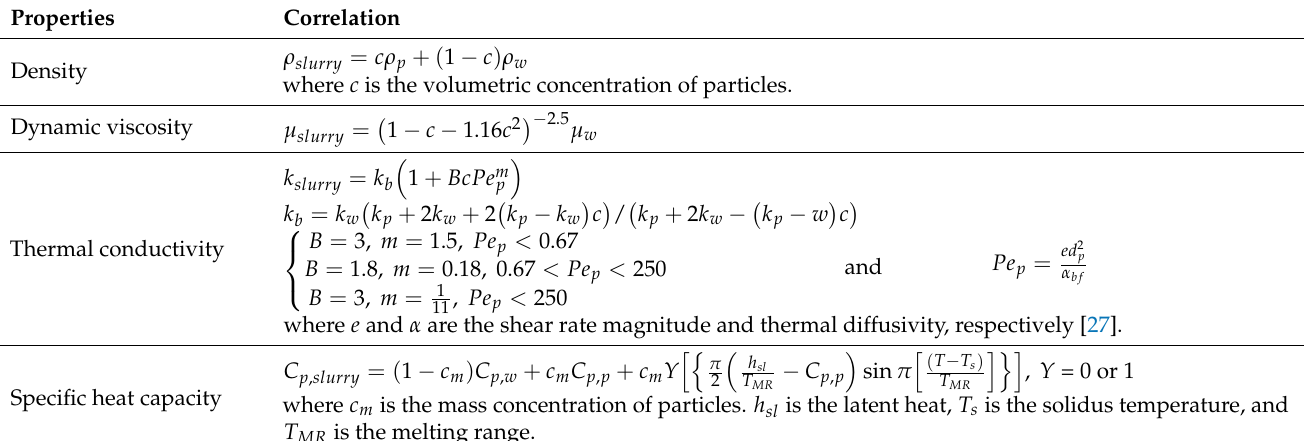
Table 4. Correlations for modelling effective physical properties